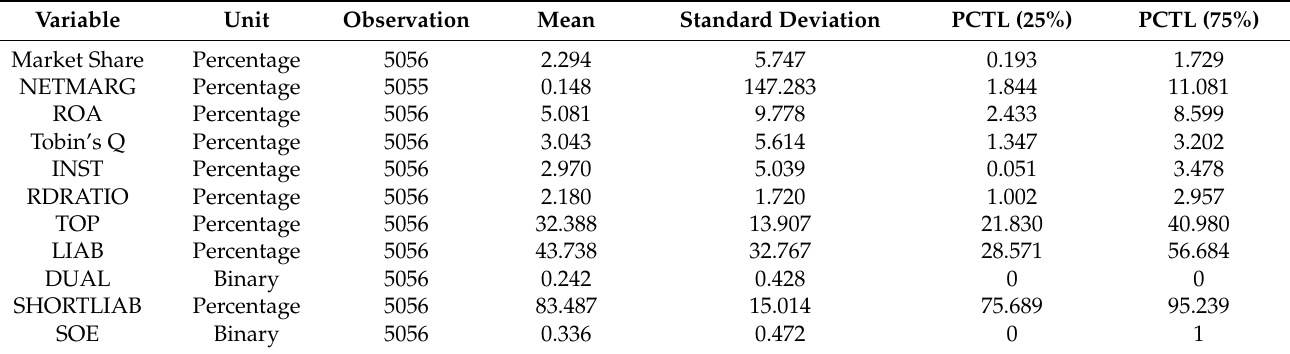
Table 1. Descriptive statistics.